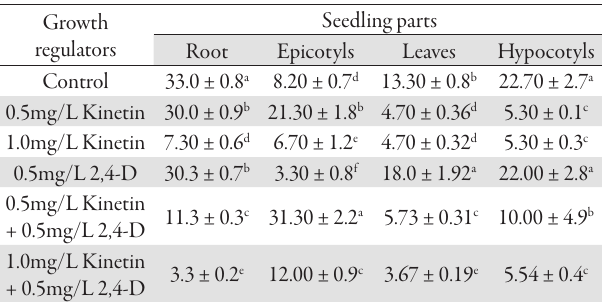
Tab. 2. Effect of different concentrations of kinetin, 2, 4-D as well as effect of some seedling parts on essential oil contents (%) (mg/100g) for callus of fennel ( Foeniculum vulgare )